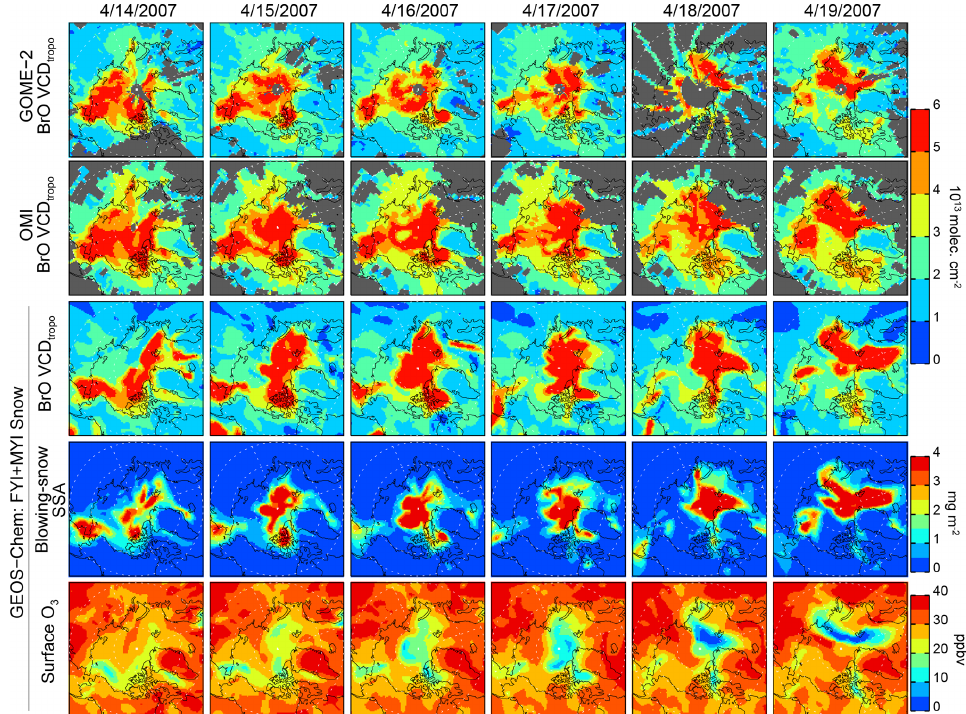
Figure 6. Daily 14–19 April 2007 (in the date format of month/day/year) distribution of BrO VCD tropo from GOME-2, OMI, and GEOS- Chem (FYI+MYI Snow simulation). Also shown are the blowing-snow SSA burdens (mgm − 2 ) and surface O 3 mixing ratios (ppbv) in the FYI+MYI Snow simulation.